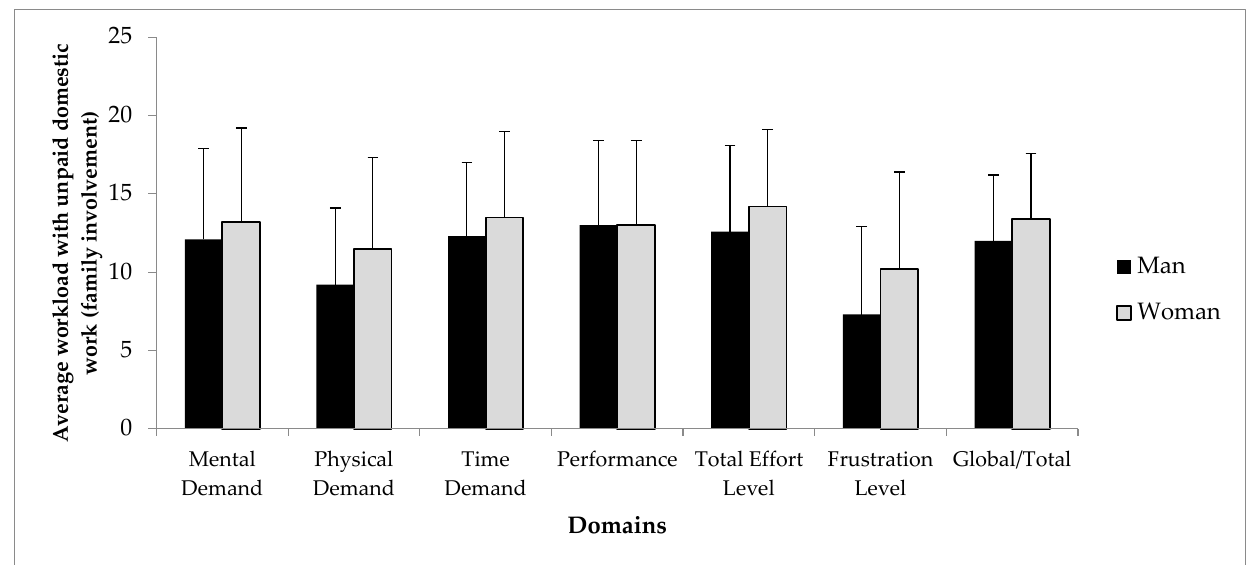
Figure A3. Averages of the workload domains of family involvement according to the professional’s gender. Error bars represent standard deviation.